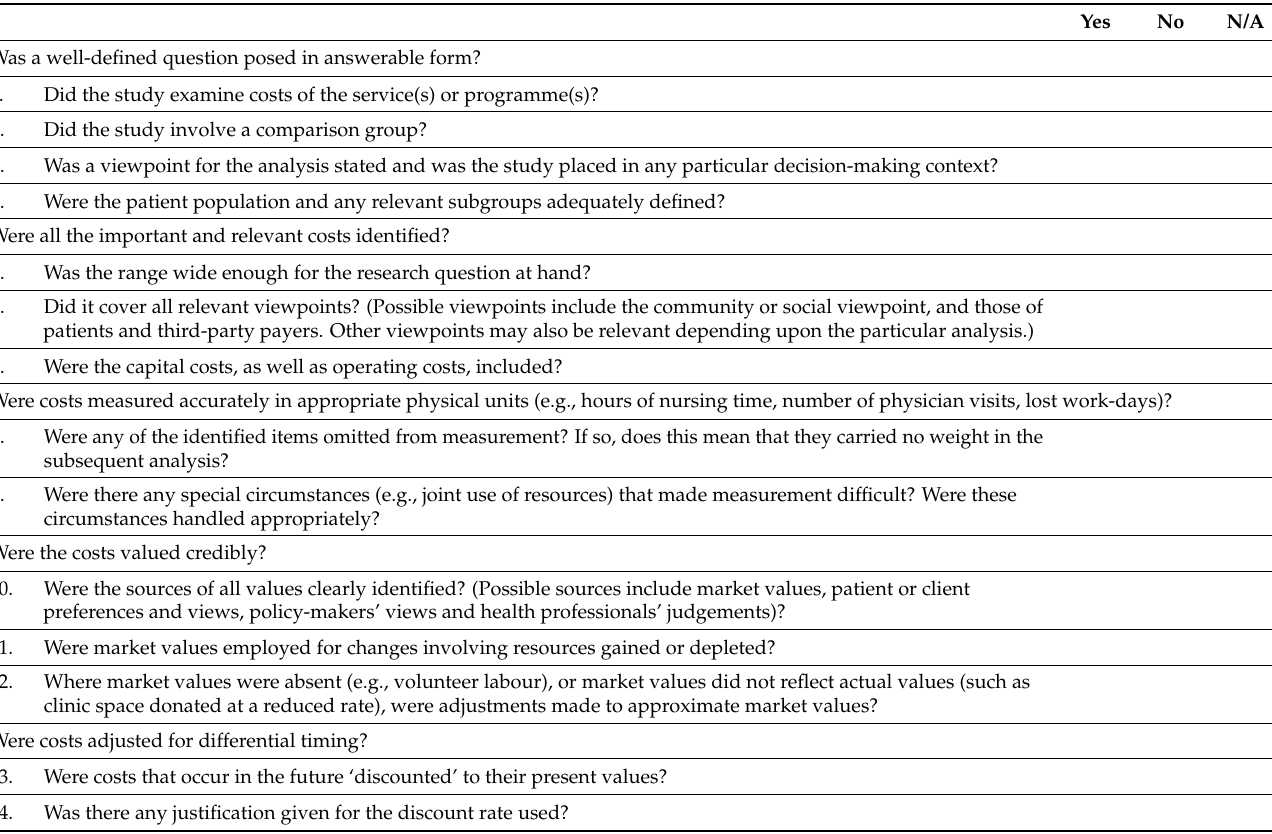
Table A1. Checklist Used for Critical